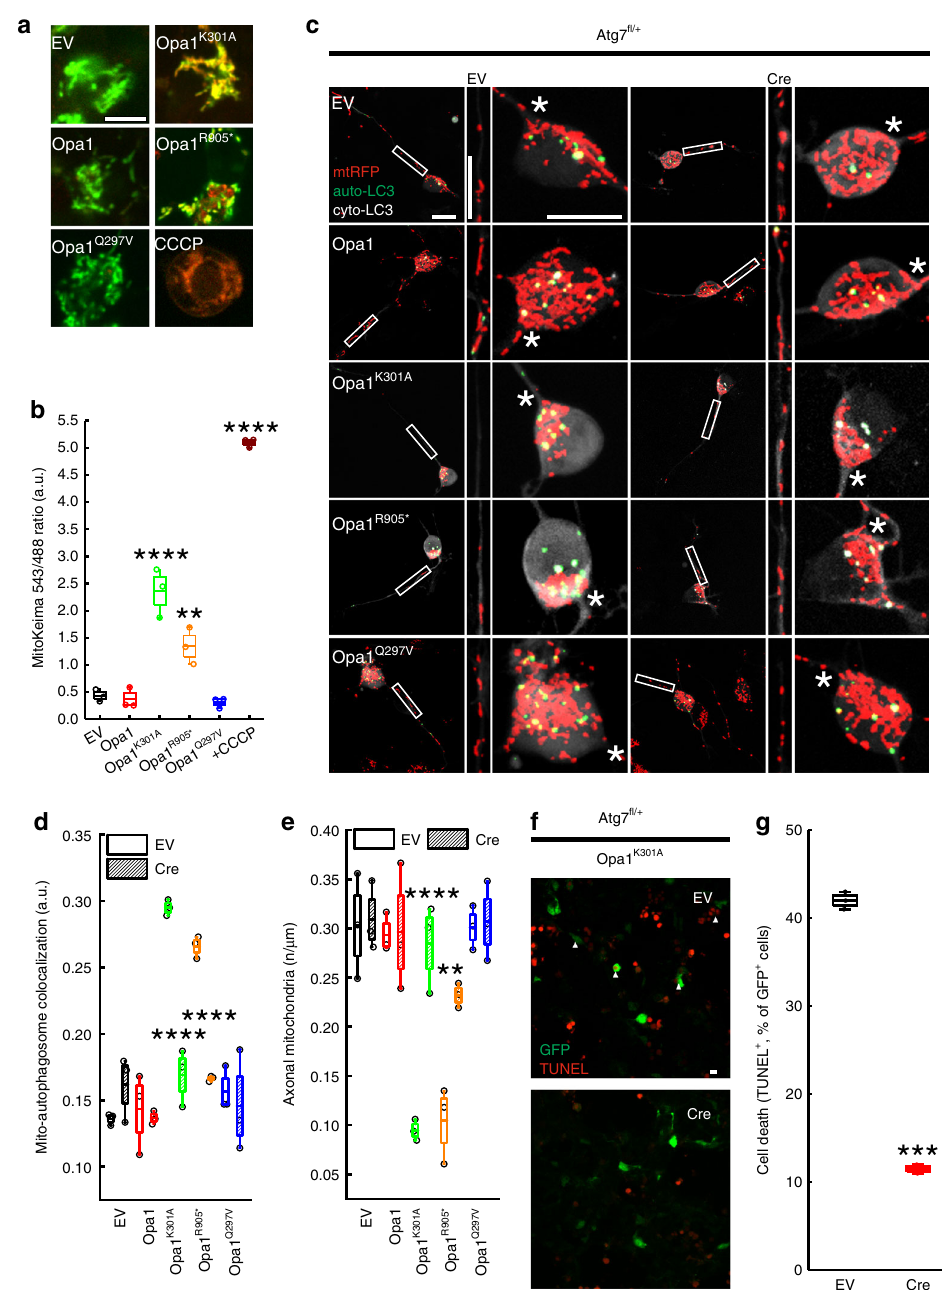
Fig. 2 Inhibition of autophagy restores mitochondrial content in ADOA RGCs axons. a Representative z-projections of stacks of confocal images of mitoKeima fl uorescence in RGCs 24h after cotransfection with the indicated plasmids. Where indicated, empty vector (EV) cotransfected cells were